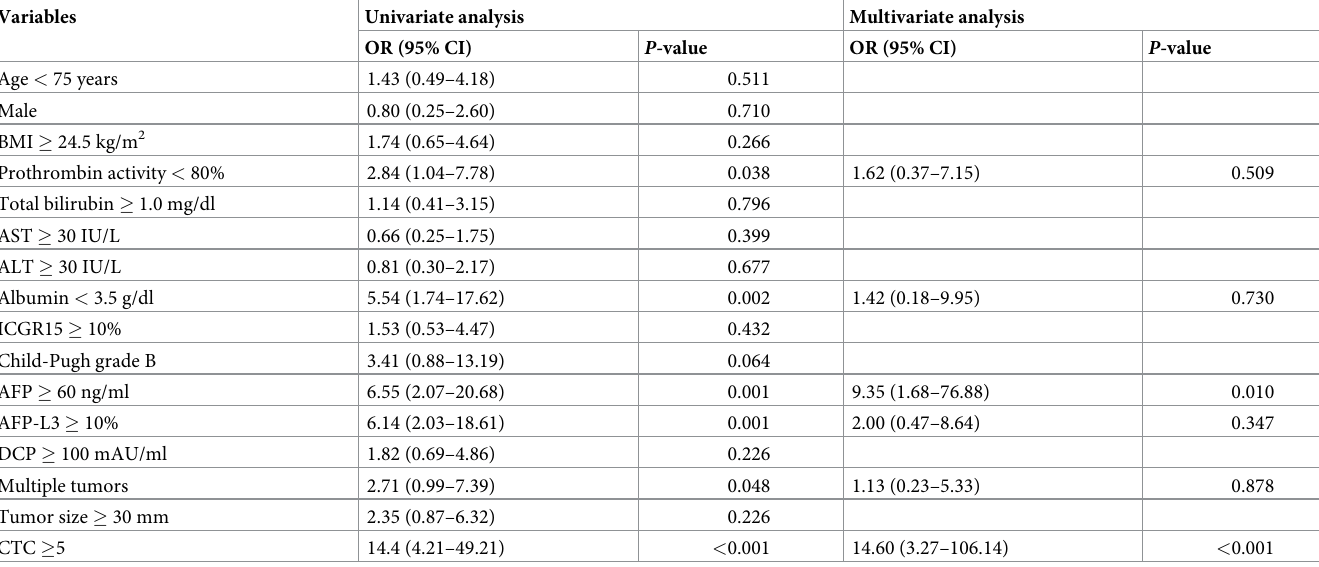
Table 3. Preoperative factors associated with microscopic portal vein invasion.